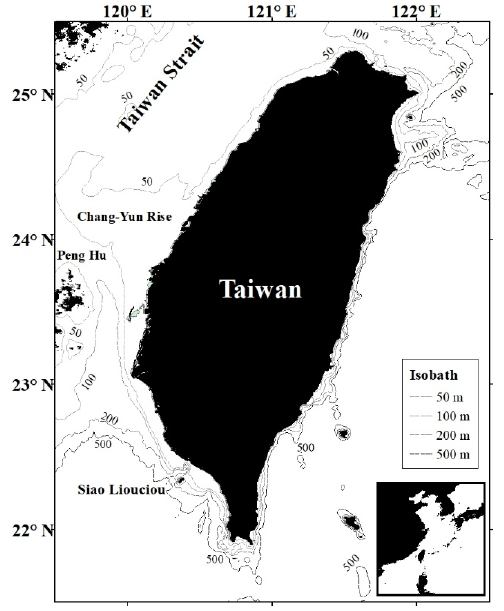
Figure 1. Map of study area (21.5° N–25.5° N and 119.5° E–122.5° E) and topographic features (isobaths as shown in dotted line).